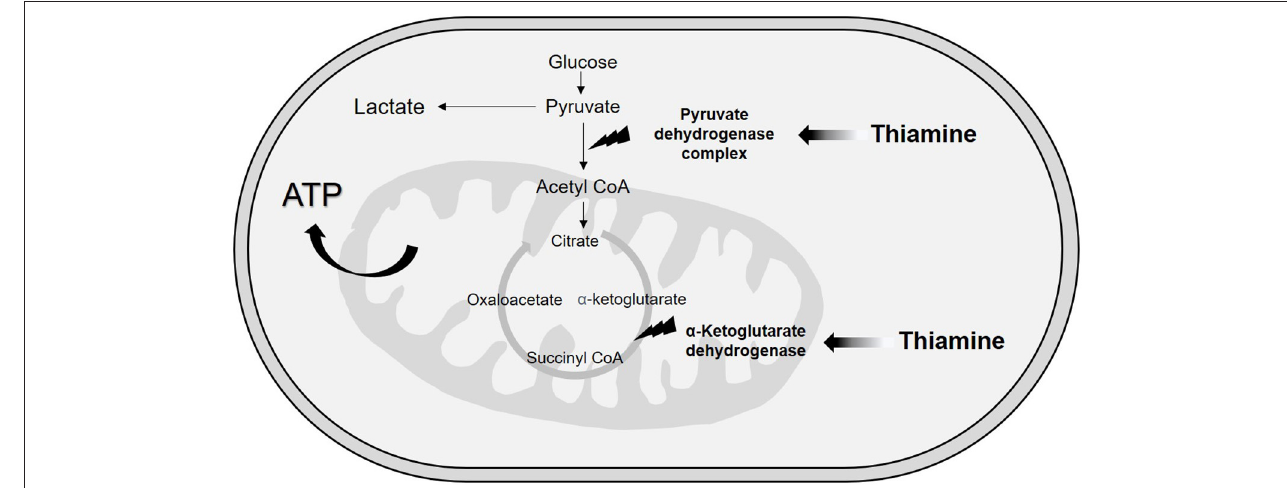
FIGURE 2 | Metabolic function of